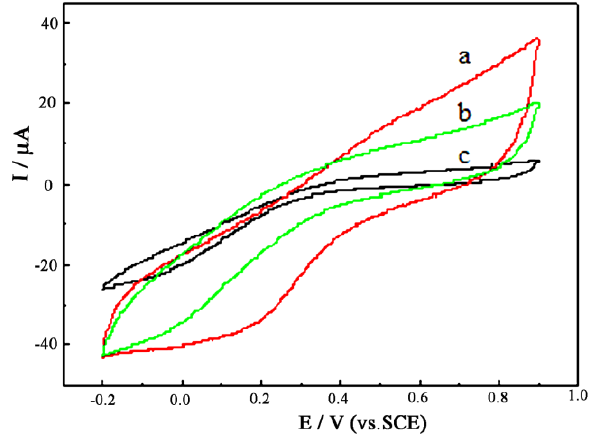
Figure 10. The cyclic voltammograms of samples: a, PANI; b, γ-Fe 2 O 3 /PANI and c, γ-Fe 2 O 3